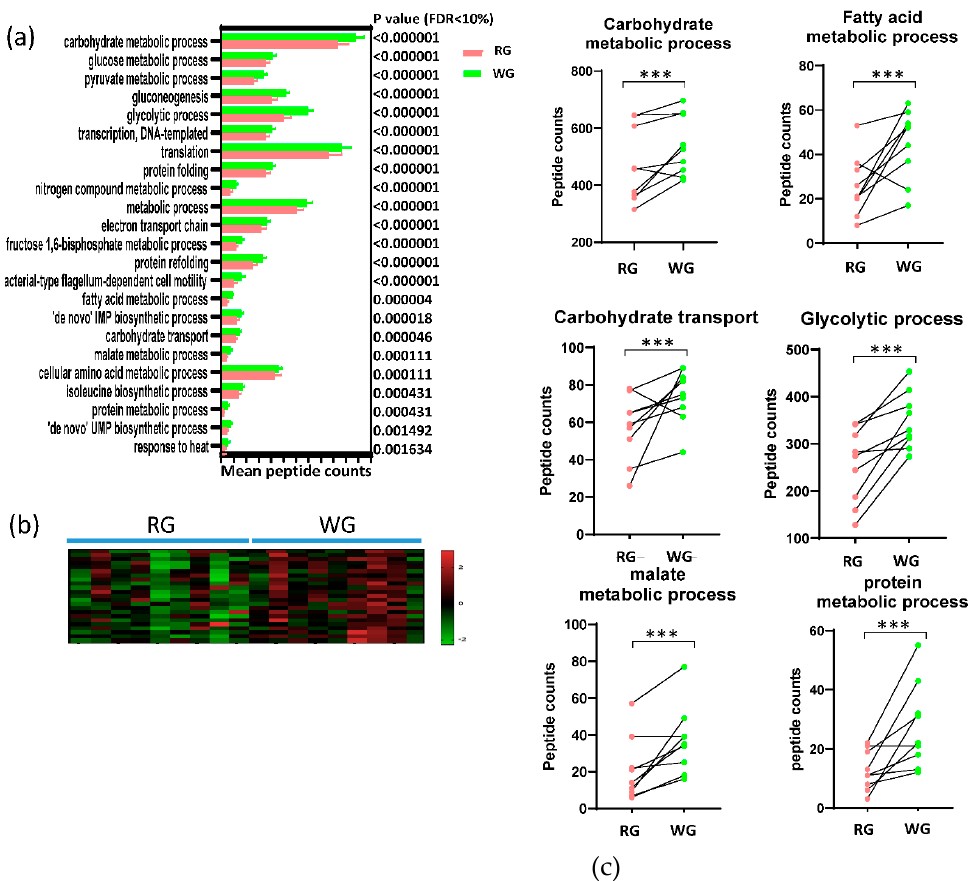
Figure 4. Significant di ff erences in GO biological processes. ( a ) Biological processes that were significantly di ff erent between the two diets; ( b ) Heat map of the significant biological processes; Microorganisms 2020 , 8 , x FOR PEER REVIEW ( c ) Selected biological processes. * p < 0.05, ** p < 0.01. *** p < 0.001.